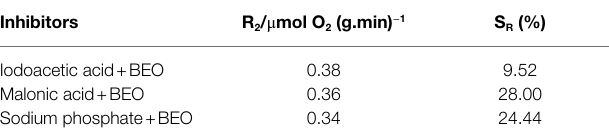
TABLE 2 | The superposition rate (S R ) of BEO and typical inhibitors.